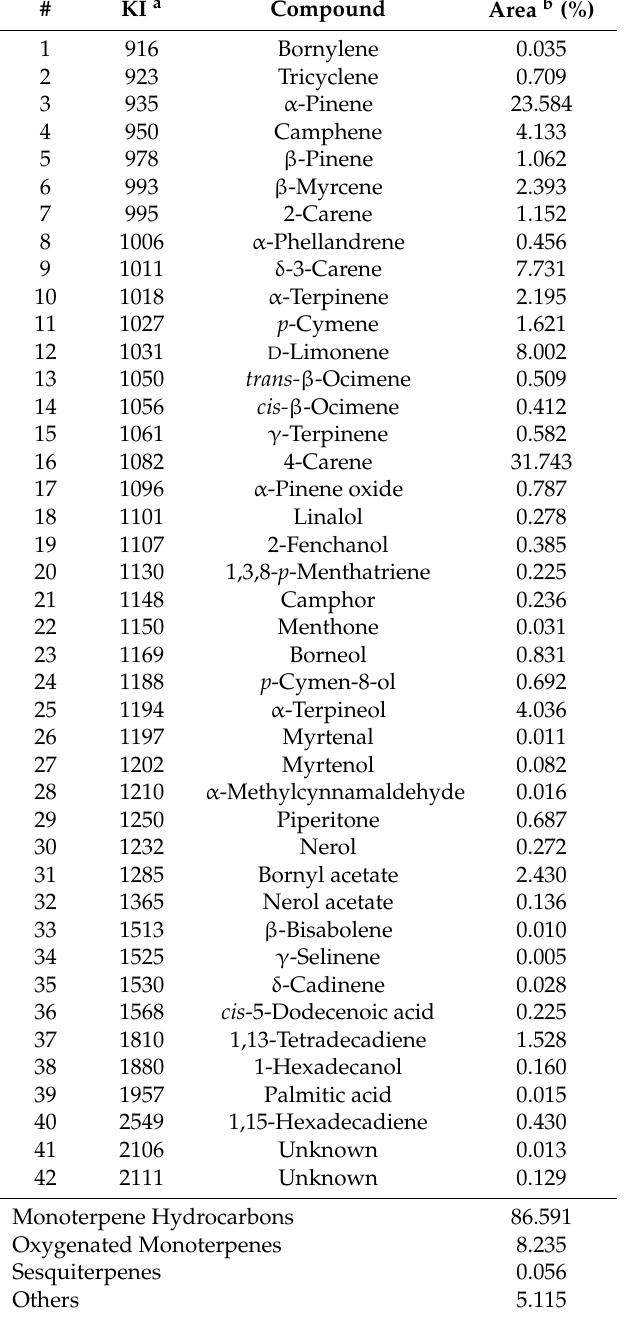
Table 1. Chemical composition of Pistacia vera L. variety Bronte hull essential